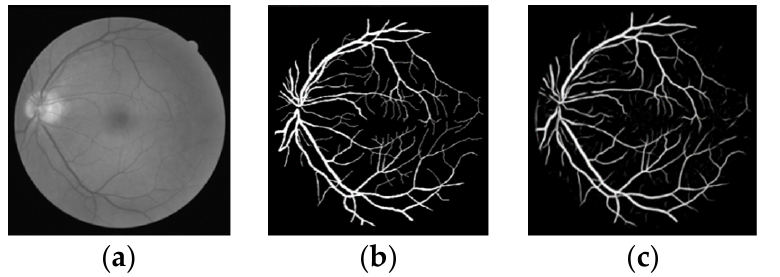
Figure 8. Third group of segmentation results ( a ) original image ( b ) gold standard image ( c ) seg- mentation results of this paper.